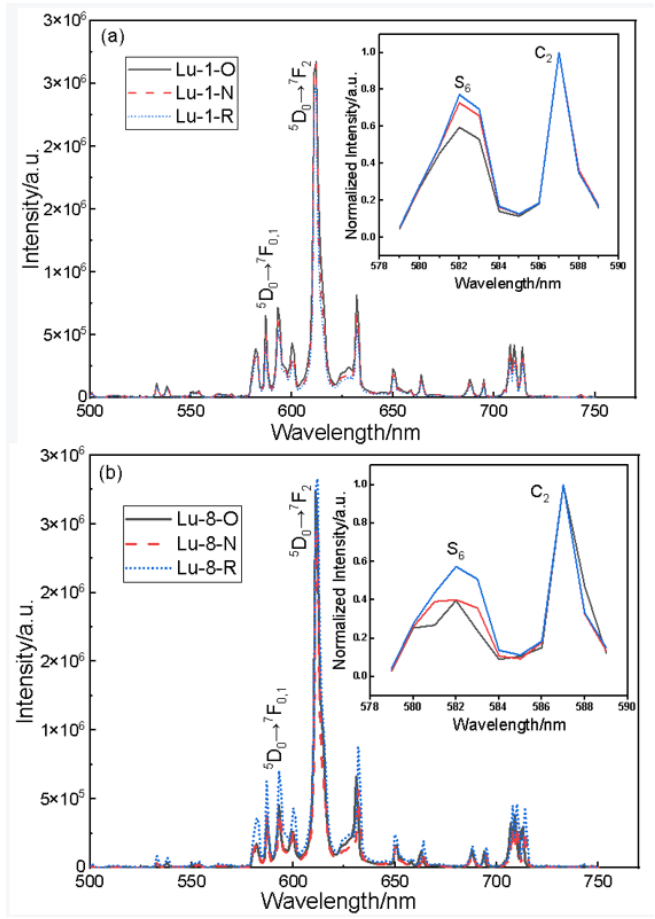
Figure 6. Emission spectra of Lu 2 O 3 :1%Eu and Lu 2 O 3 :8%Eu single crystals measured under X-ray excitation. The inserts of ( a ) and ( b ) present a normalized intensity for the range of 579–590 nm.